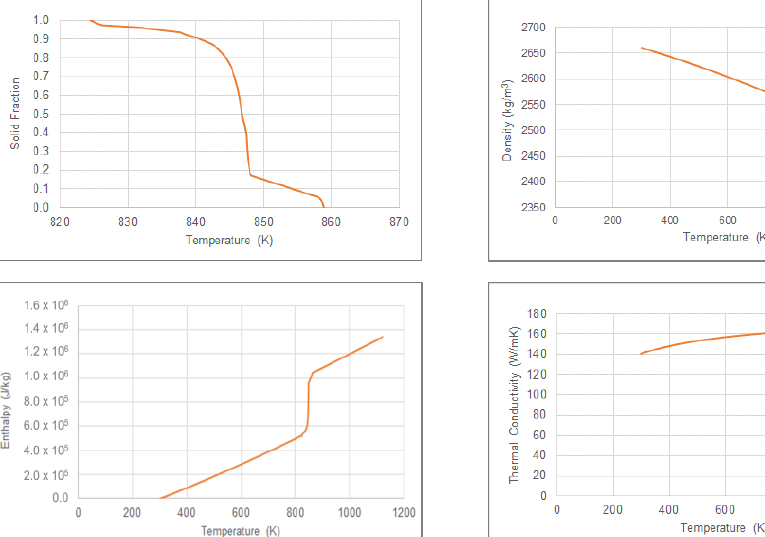
Figure 6. Thermo-physical properties obtained.